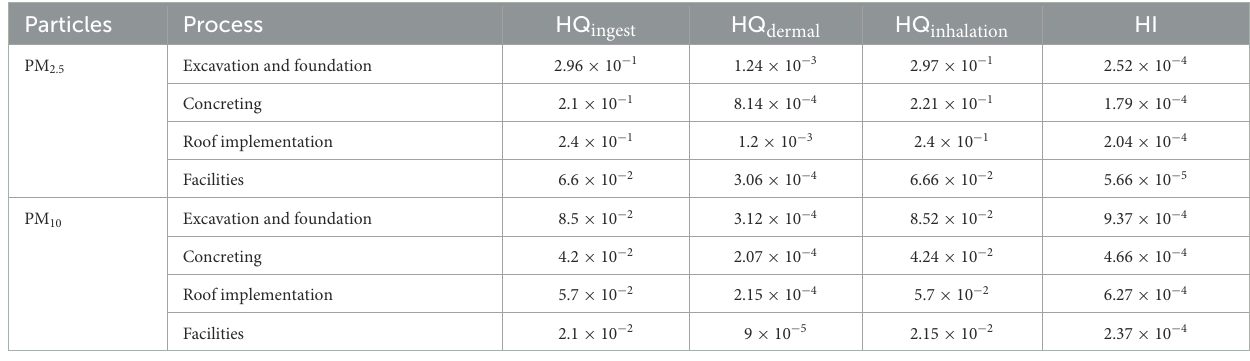
TABLE 3 Risk potential values and risk index for non-cancer risks of PM 2.5 and PM 10 .